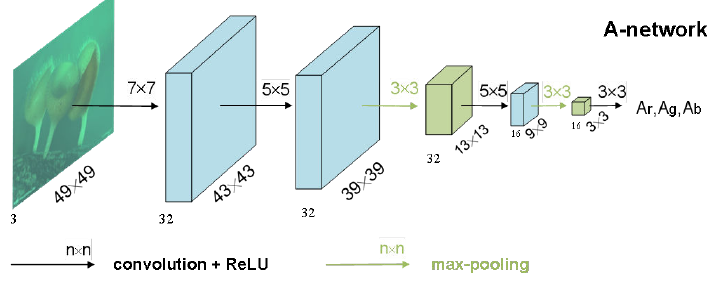
Figure 4. The architecture of